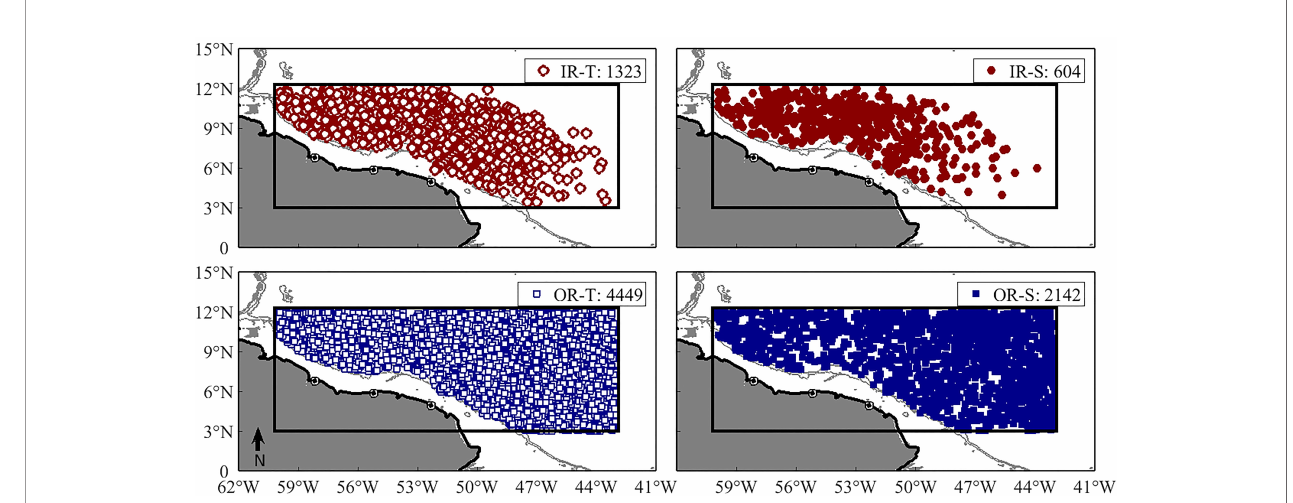
FIGURE 2 | Spatial distribution of the Inside Ring (IR) pro fi les (upper panels) and Outside Ring (OR) pro fi les (lower panels) within the searching area from 1993 to 2016, from the EN4.2.0 dataset. Empty markers (left panels) indicate T pro fi les, while fi lled markers (right panels) indicate S pro fi les. The rectangle de fi ned by solid lines delineates the searching area (see text and Figure 1 for details). The gray lines are the 200 and 1000 m